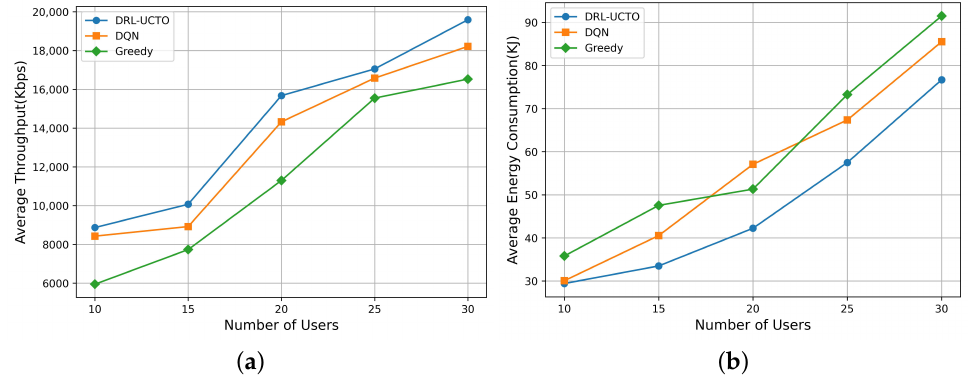
Figure 6. Comparison of system average throughput and average energy consumption under a different number of user scenarios. ( a ) System average throughput versus number of users. ( b ) System average energy consumption versus number of users.